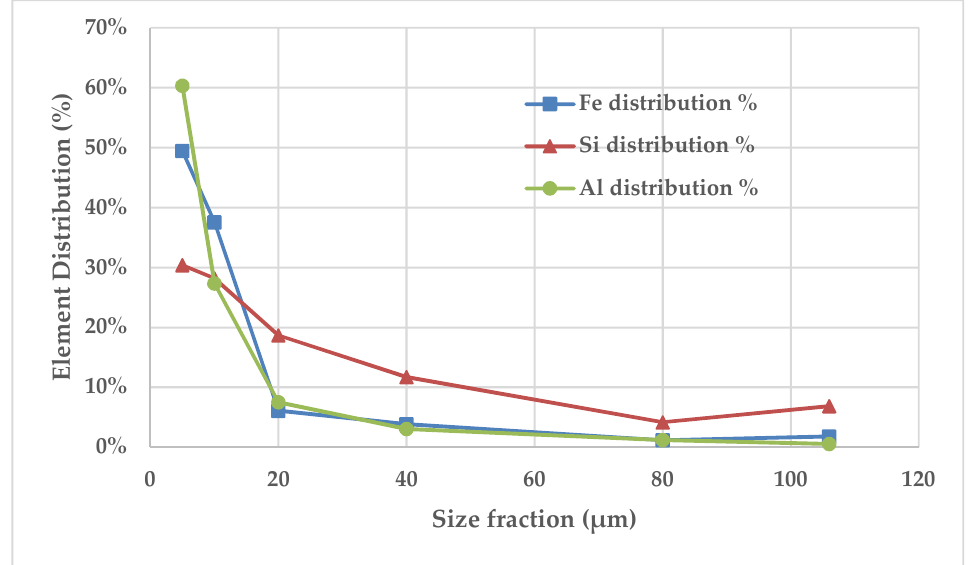
Figure 2. Distribution of Fe, Si and Al according to size fraction of the iron ore slime (sample 1).